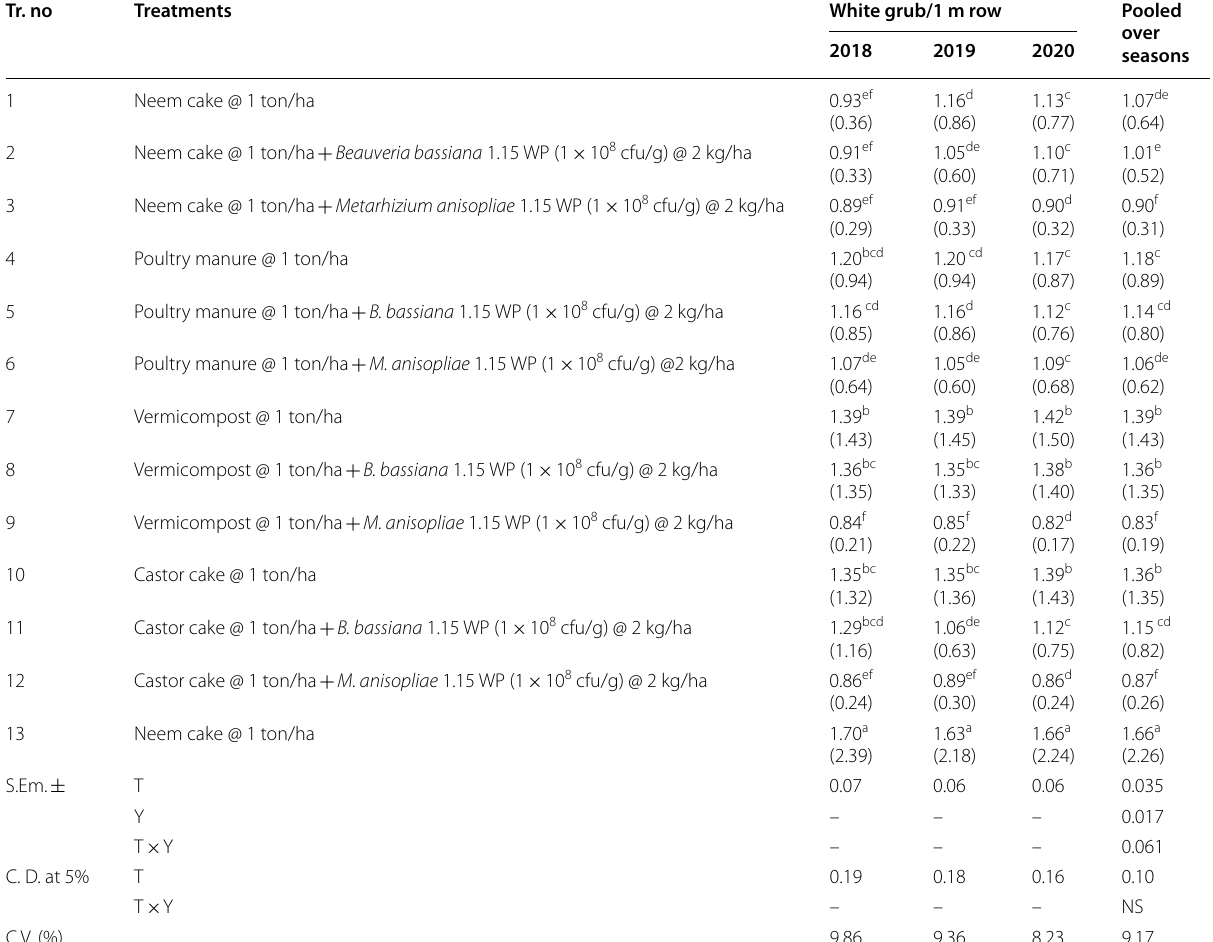
Table 7 Effect of entomopathogenic fungi enriched with organic amendments against white grub/1 m row in groundnut (pooled over seasons) Tr. no